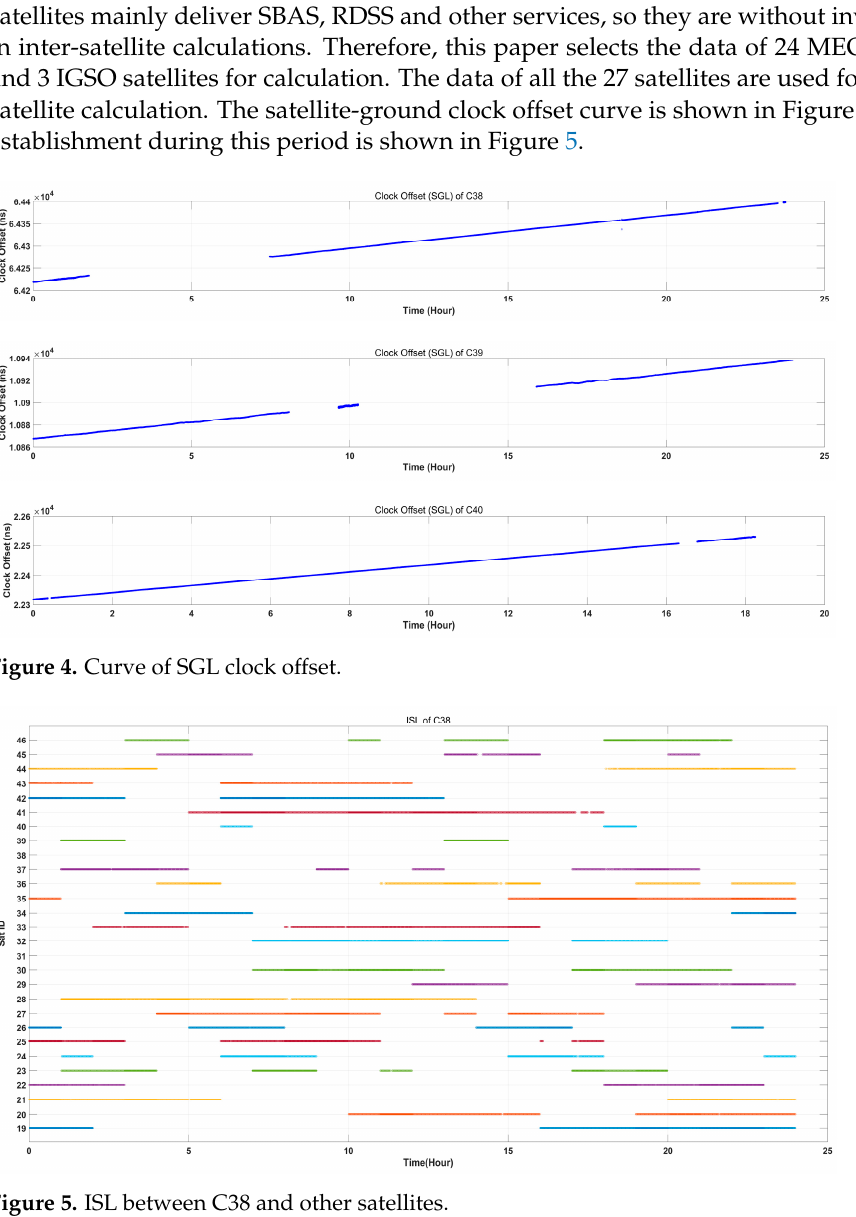
Figure 5. ISL between C38 and other satellites.